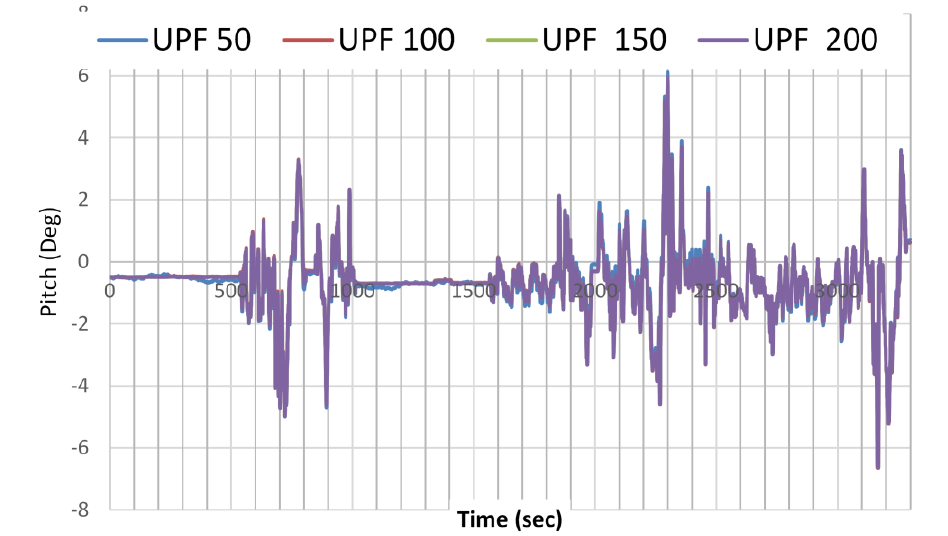
Figure 9. Pitch angle estimation as a function of number of samples used by